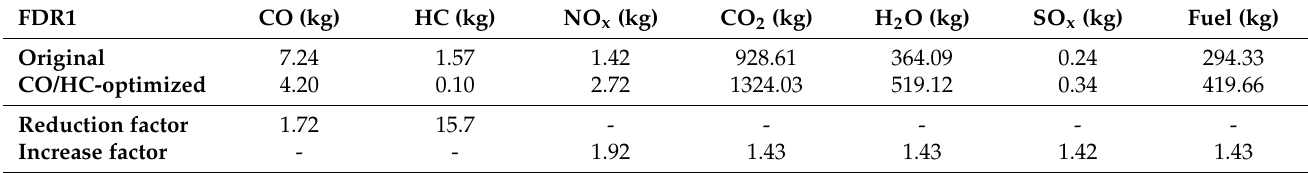
Table 4. Comparison of total level of emissions and burned fuel for the simulated FDR1 descent trajectory: original and